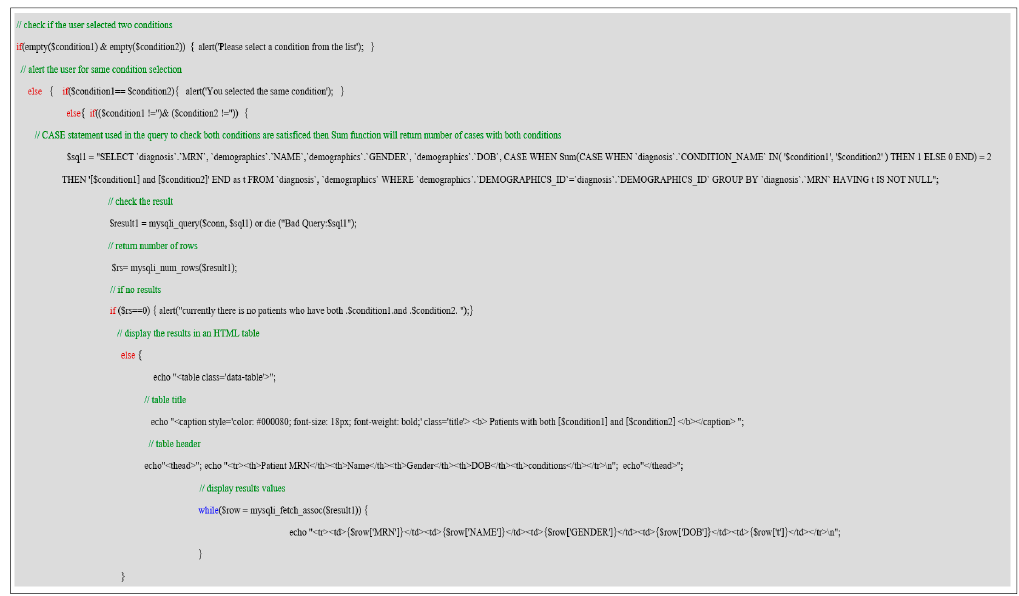
Figure 18. Advanced query to display patients with two selective conditions.